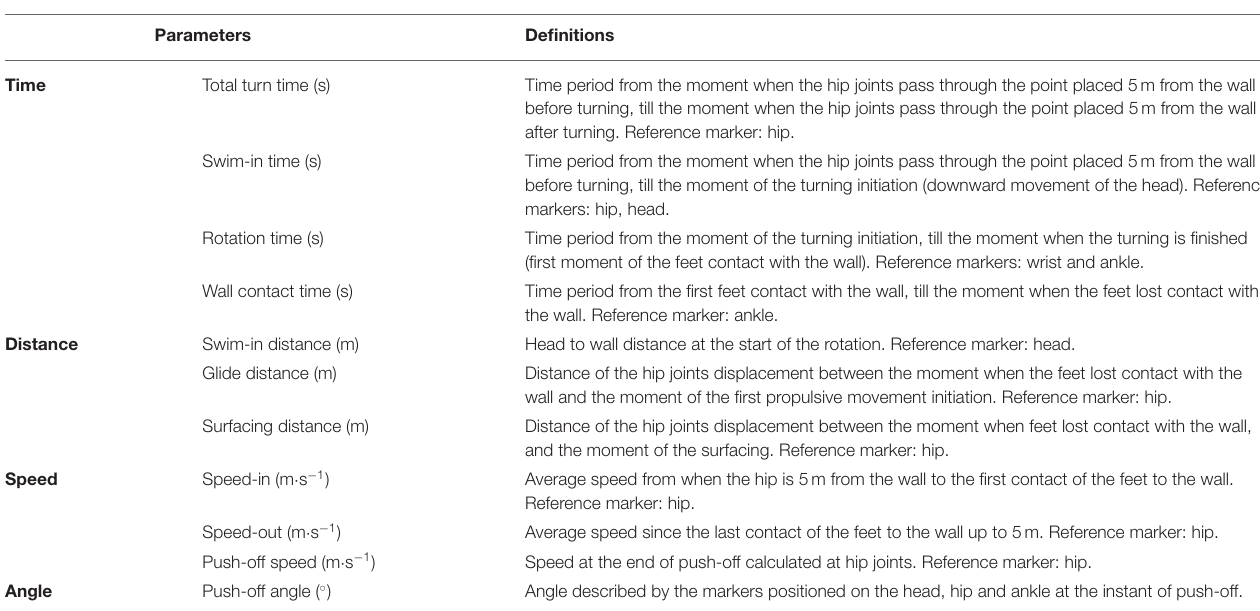
TABLE 2 | Parameters’ specification and description and reference